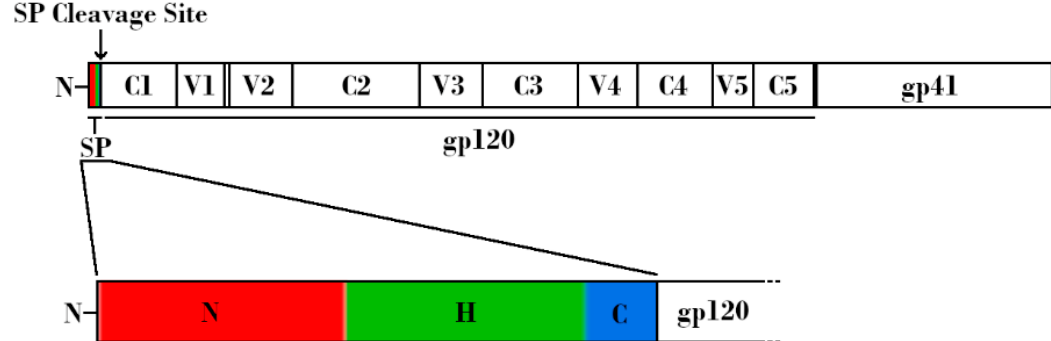
Figure 1. Schematic linear representation of the nascent HIV-1 Envelope (Env) protein attached to the HIV-1 signal peptide (SP). (Top) Regions corresponding to SP, glycoprotein 120 (gp120), and glycoprotein 41 (gp41) are indicated. Variable and constant regions of gp120 are indicated by V1-V5 and C1-C5, respectively. SP cleavage site is indicated by an arrow. (Bottom) Expanded schematic representation of the HIV-1 SP. The N-terminal hydrophilic positively charged region is shown in red, the central hydrophobic region is shown in green, and the slightly polar C-terminal region is shown in